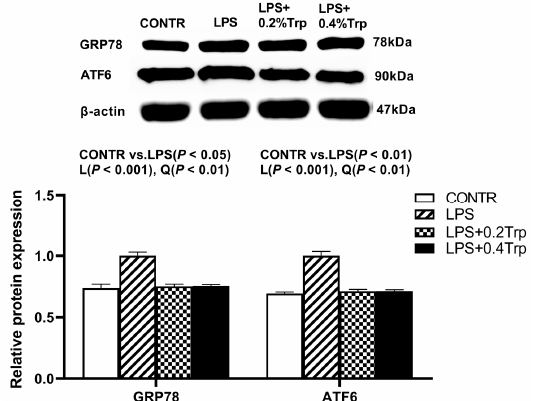
Figure 2. Impact of tryptophan supplementation on the ratios of GRP78/ β -actin and ATF6/ β -actin after 4 h of E. coli LPS challenge in ileal mucosa of weaning piglets. GRP78, glucose-regulated protein-78; ATF6, activating transcription factor 6; CONTR, control; LPS, lipopolysaccharide; Trp, tryptophan. The bands represented Western blot images of GRP78 and ATF6. The data are presented as means ± SEM. CONTR vs. LPS was employed to obtain the response to LPS challenge. Linear and quadratic polynomial contrasts were employed to obtain the response of tryptophan supplementation in LPS-challenged piglets. Note: L (linear), Q (quadratic).